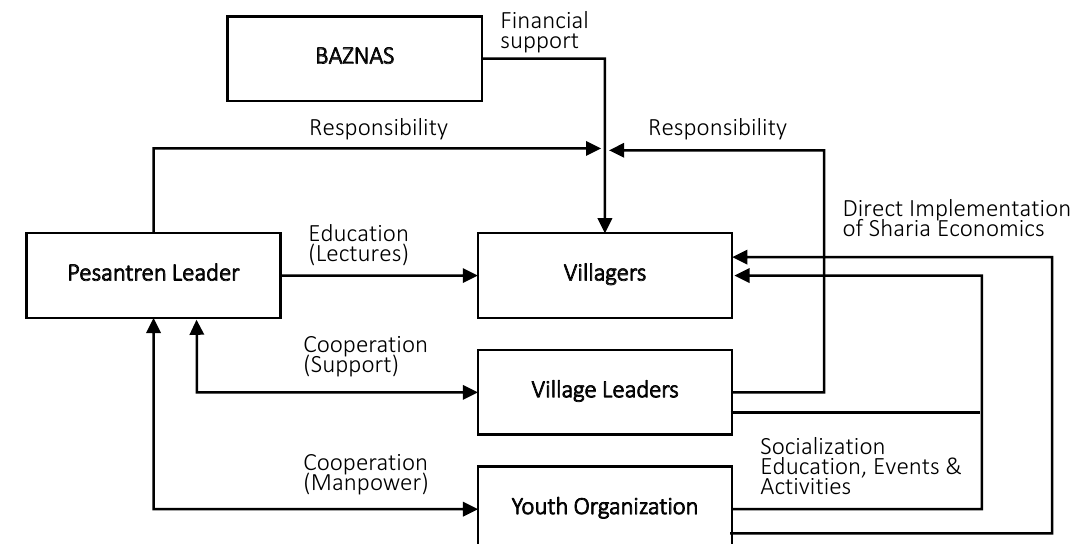
Figure 1. The cooperative relationship of all parties in developing Gerdu